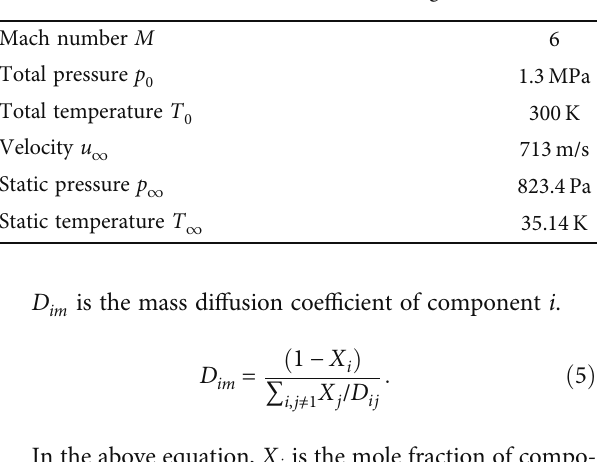
Figure 5: Schematic diagram of the physical model in reference [28]. Table 2: Parameters of the incoming fl